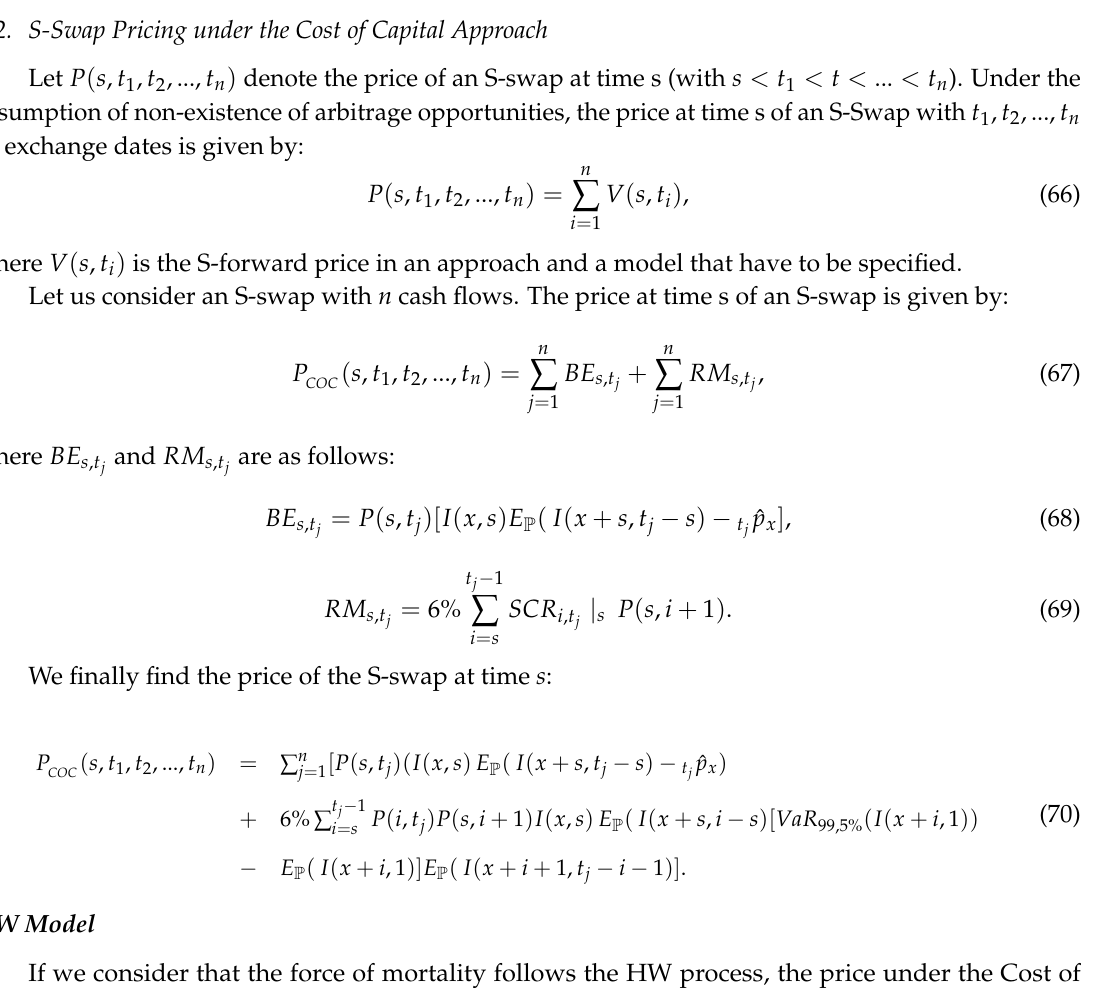
Figure 6. S-swap